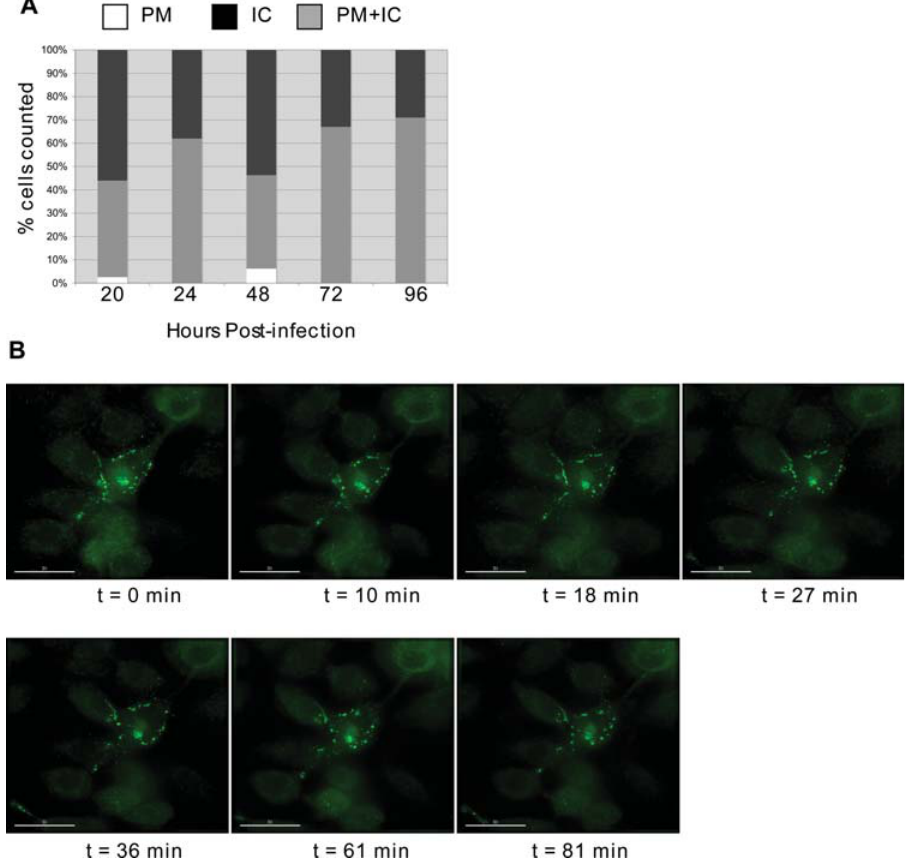
Figure 4. Gag localization in MDMs remains stable over time. (A) MDMs were labeled with FlAsH 20, 24, 48, 72, and 96 hrs after infection with VSV-G-pseudotyped NL4-3/MA-TC. At each time point, between 25 and 65 cells were categorized as having PM, intracellular (IC), or both PM + intracellular (PM + IC) Gag localization. (B) Live-cell analysis. MDMs infected with VSV-G-pseudotyped NL4-3/MA-TC virus were labeled with FlAsH 48 hrs postinfection, and immediately examined microscopically on the stage in a closed chamber (37 u C/5% CO 2 ). Time (t) represents time in min after FlAsH labeling. Scale bar=30 m m.